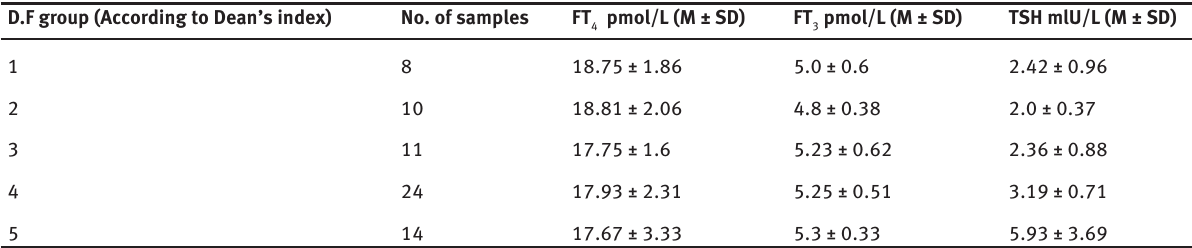
, FT and TSH in RM Participants. 4 3